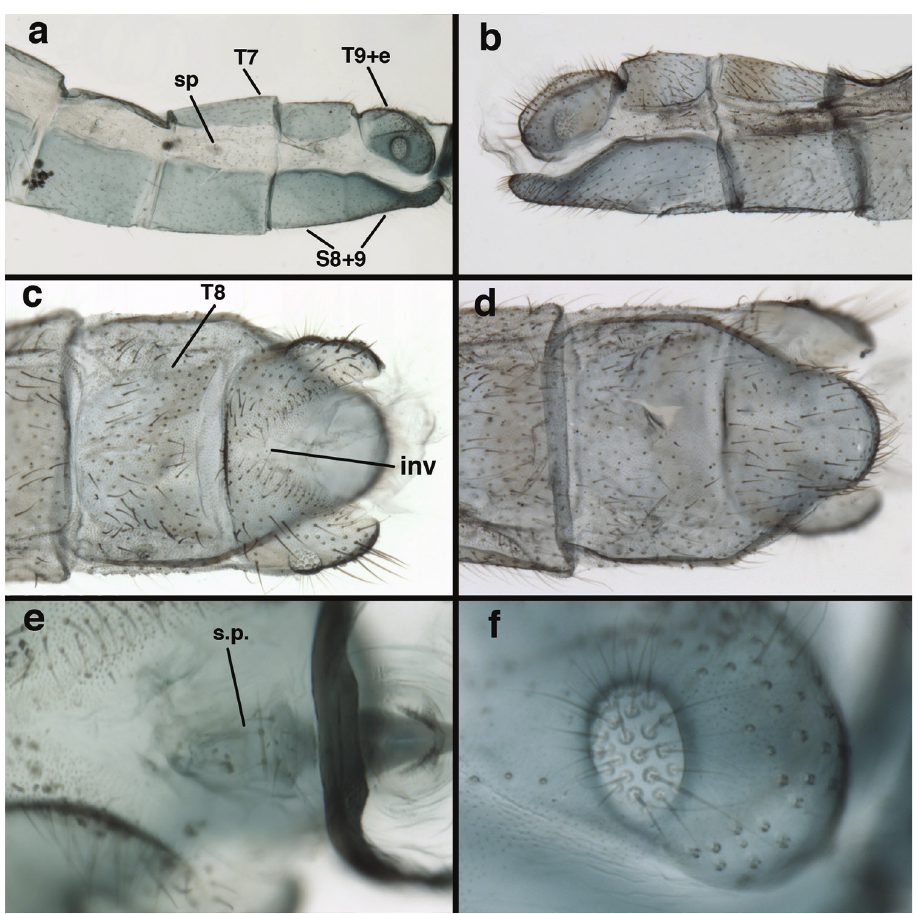
Figure 105. Ungla argentina (Navás): Male abdomen, ( a, b ) segments A6-terminus, lateral ( c ) tergites T8 and T9+ectoproct, dorsal ( d ) fused sternites S8+9, ventral ( e ) terminus, dorsal ( f ) callus cerci. inv invaginated dorsal cleft in T9+ectoproct sp spiracle s.p. setose subanal plate S8+9 fused eighth and ninth sternites T7 seventh tergite T8 eight tergite T9+e fused ninth tergite and ectoproct (Argentina; a, e, f Tucumán, CAS; b, c, d Santiago del Estero,